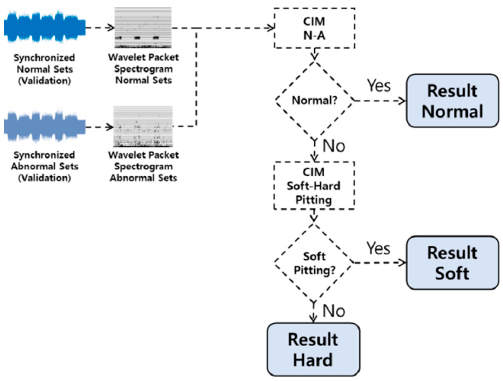
Figure 11. Flow chart of classifier.